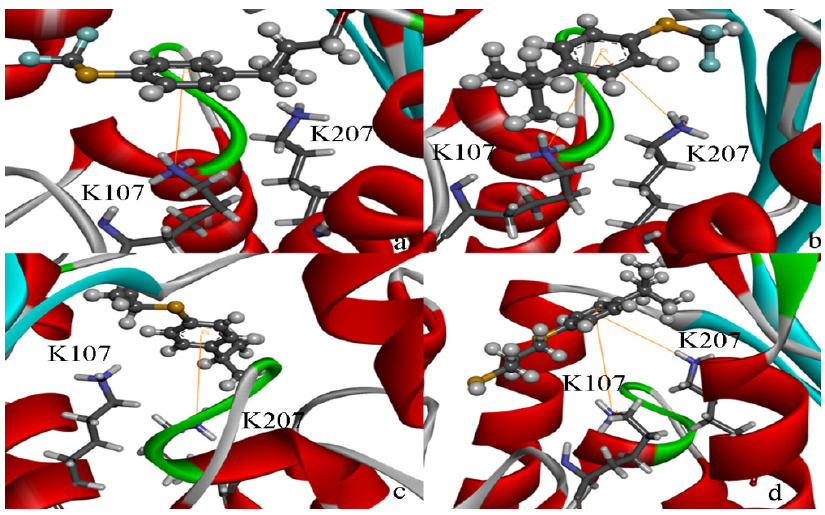
Figure 8. Predicted binding modes of ligands found from the homology model screen. ( a – d ) Predicted binding poses for four ligands discovered in the docking screen against the HSD homology